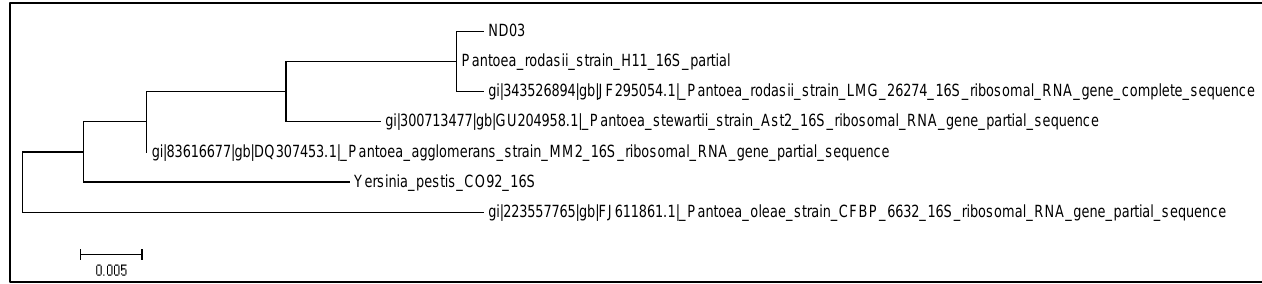
Figure 2. Phylogenetics analysis of strain ND03. The tree with the highest log likelihood (−917.0500) is shown. The tree is drawn to scale, with branch lengths measured in the number of substitutions per